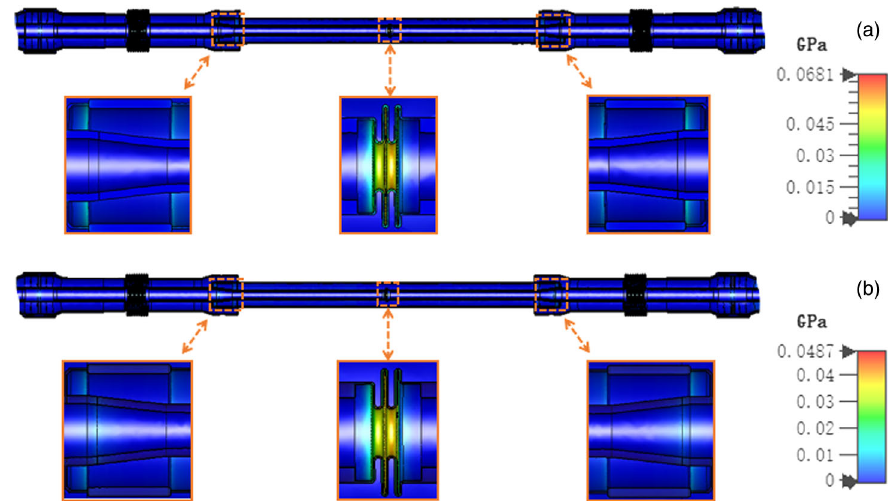
FIG. 12. Thermal stress distributions of the fundamental couplers with 2.5 kW of power in the cavity. The left short in (a) locates at z ¼ − 30 cm, and (b) at z ¼ − 76